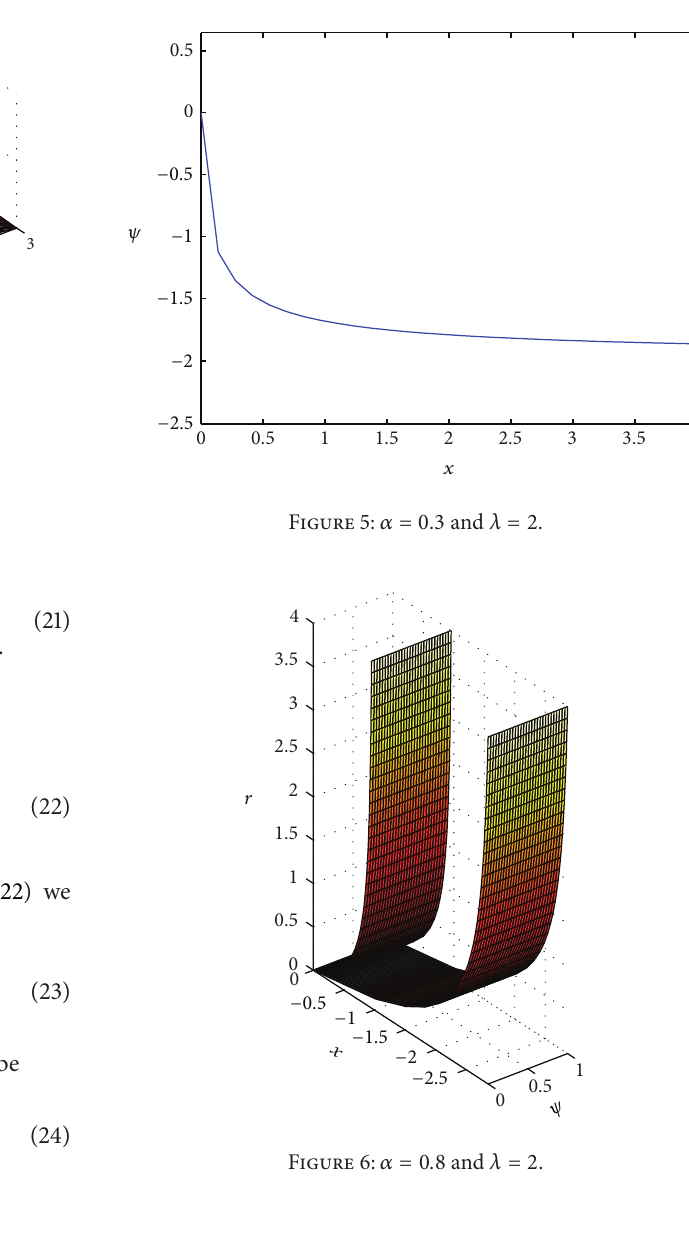
Figure 6: 𝛼 = 0.8 and 𝜆 = 2